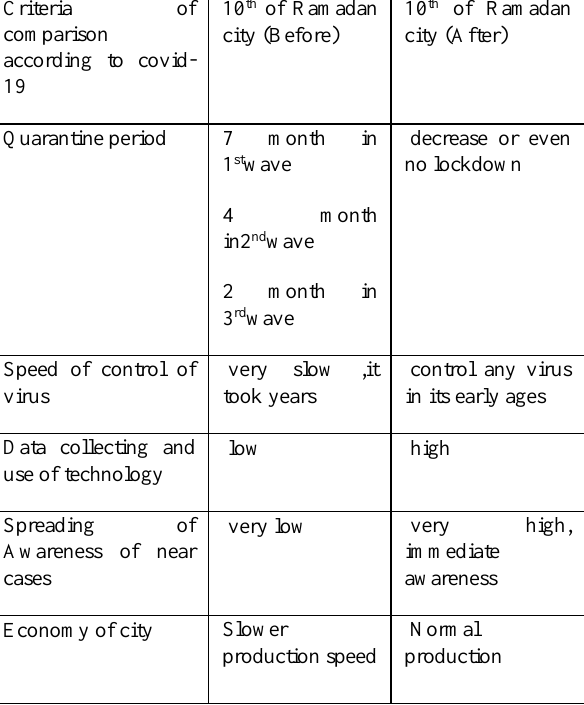
Table 3. Comparison before and after the 10th of Ramadan city (researcher,